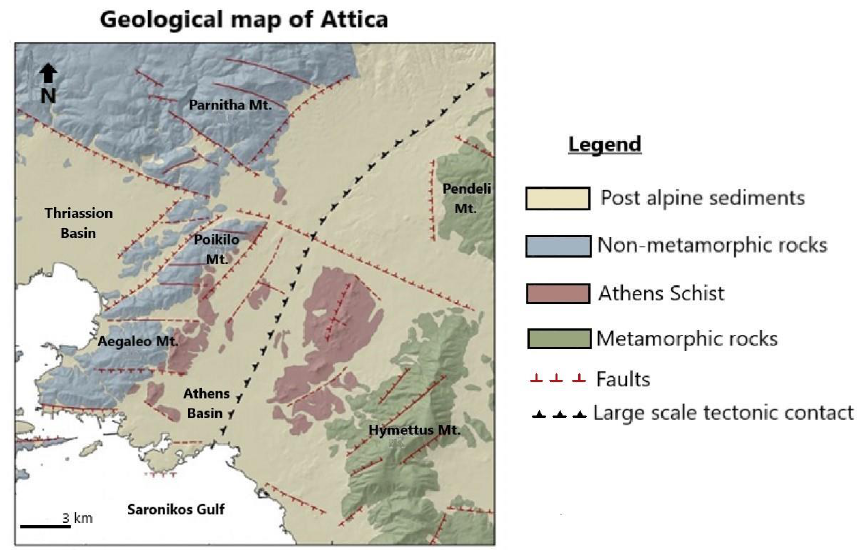
Figure 2. Simplified geological map of the basin of Attica [23], modified by us. Inside the basin, a series of hills, the altitudes of which decreases towards the SW, has developed along the central axis in a NE-SW direction (Figure 3). The main ones, from north to south, are the Tourkovounia (339 m), Lykabettus (278 m), the Acropolis (156 m) and the Museum Hill or Filopappou (147 m), all made of a lowermost Upper Cretaceous (100 My) limestone, called locally the “Tourkovounia Formation” [24]. These hills have the same geological age and the same geological structure as the Acropolis hill. Figure 3. Satellite photo of Athens city indicating the location of the hills of the city. 1 . Akropolis, 2 . Filopappou 3 . Hill of the Nymphs 4 . Lycabettus 5 . Hill of Strefi 6 . Tourkovounia 7 . Ardittos Hill The four hills located on the surface of the basin are rocky remnants of a previous relief and are characterised as “inselberg hills,” i.e., isolated hills [25]. There are also smaller ones, such as Ardittos (131 m), Strefi Hill, the Hill of the Nymphs, and Areios Pagos.